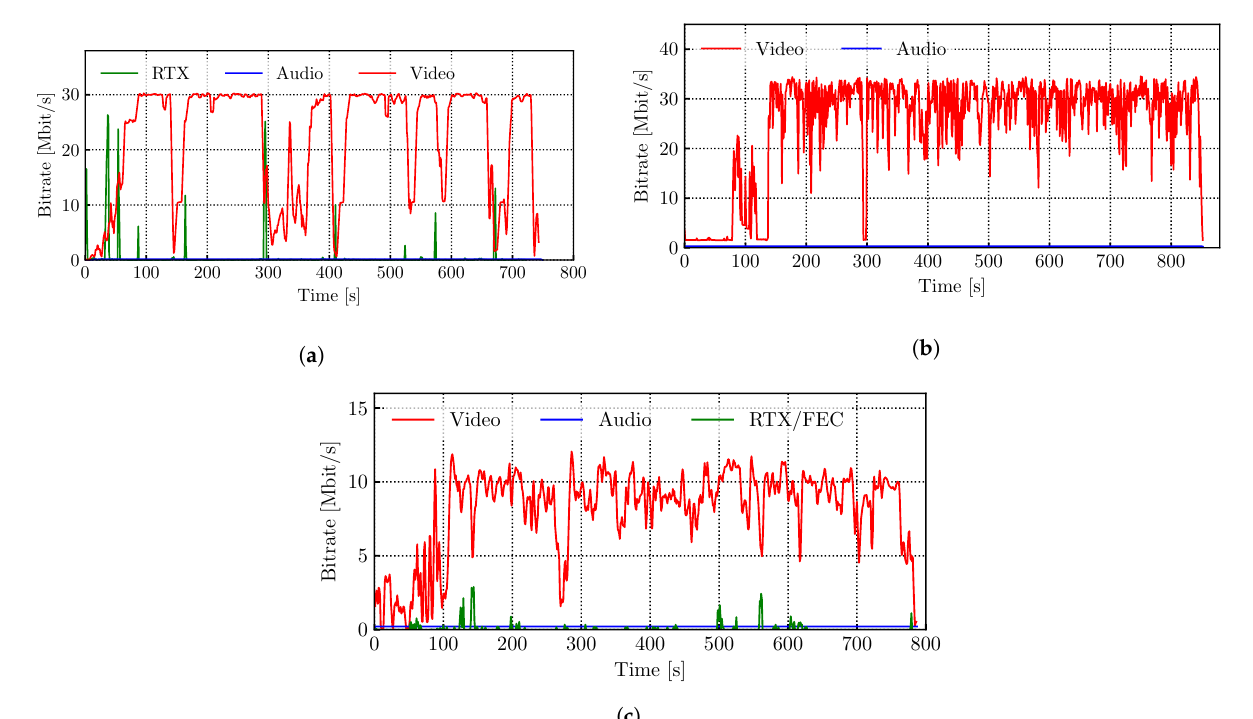
Figure 2. Examples of temporal evolution of bitrate for three gaming sessions. ( a ) Stadia (1080p). ( b ) GeForce Now (1080p). ( c ) PS Now .